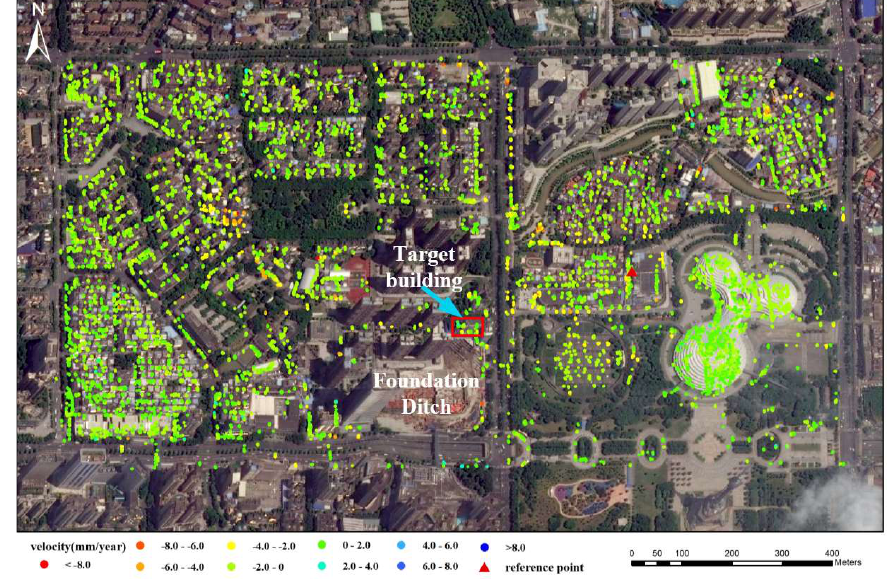
Figure 3. COSMO-SkyMed persistent scatterer pair (PSP) InSAR measurements obtained in the considered area of Foshan, China.